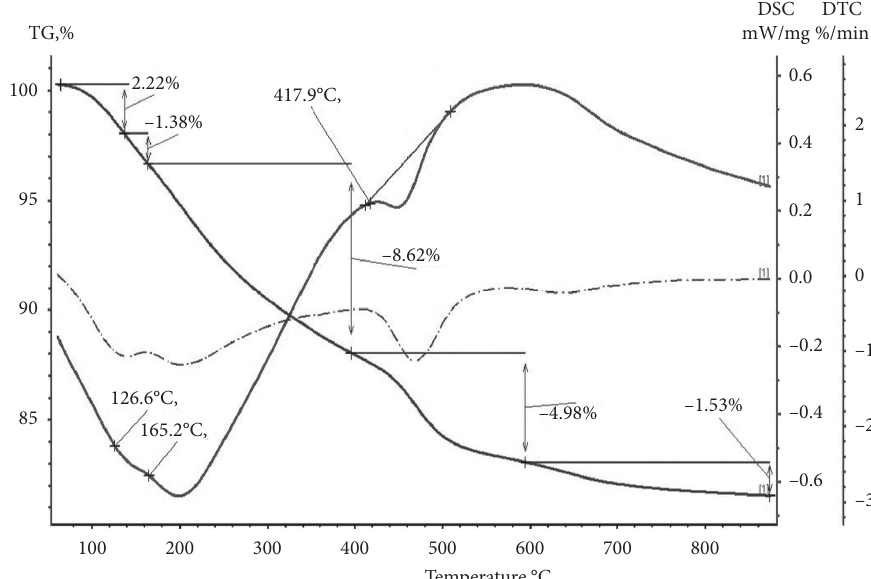
Figure 6: Differential thermoanalysis of the composition of kyanite-sillimanite (7 mass units) and orthophosphoric acid (3 mass